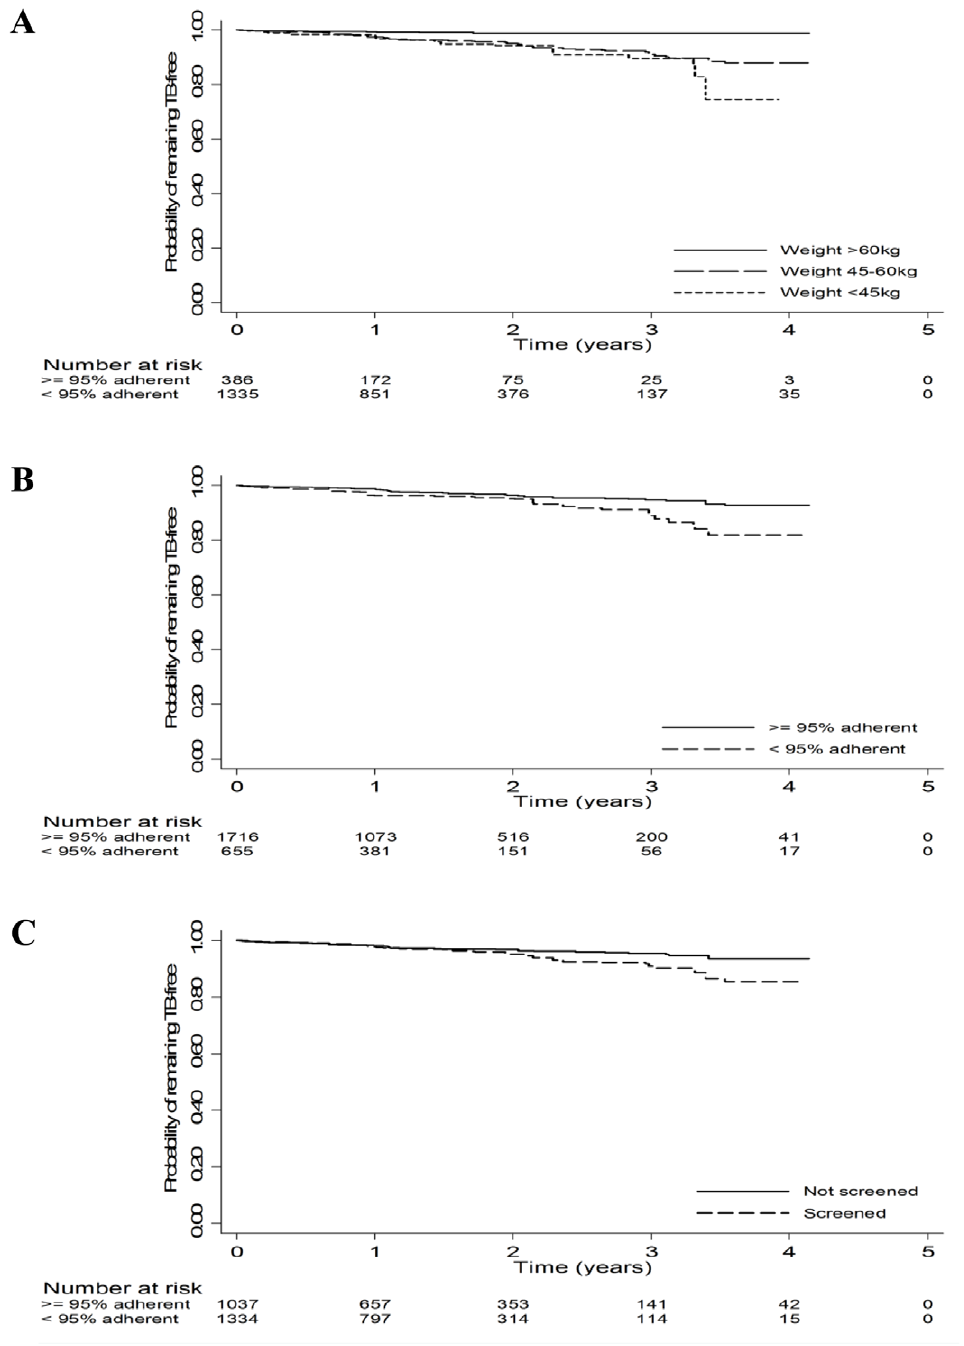
Figure 4. Kaplan Maier Analysis of TB-Free Survival. A Kaplan Meier Curve of TB Incidence Stratified by Baseline Weight. B Kaplan Meier Curve of TB Incidence Stratified by Level of ART Adherence. C Kaplan Meier Curve of TB Incidence Stratified by TB Screening at ART